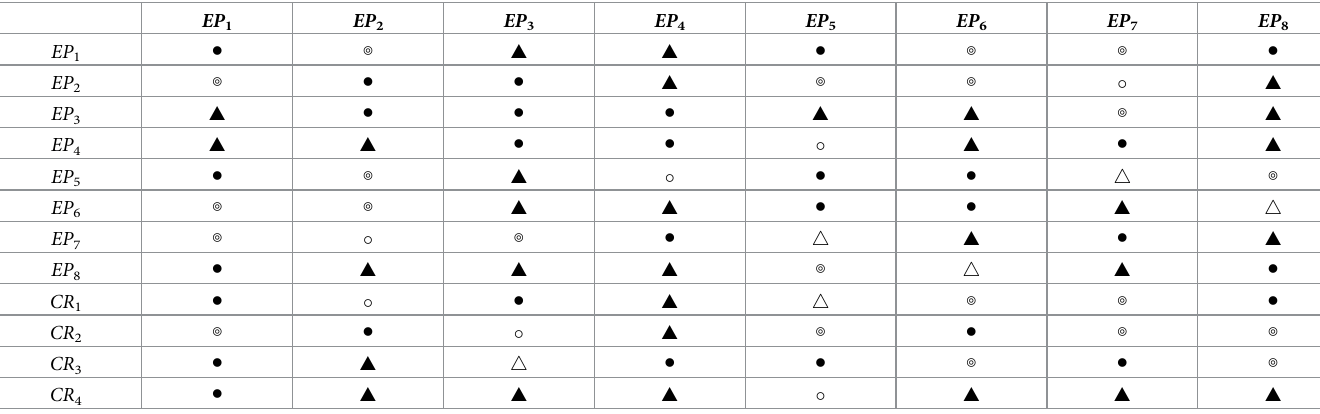
Table 8. The evaluation information in the first stage (One export). EP